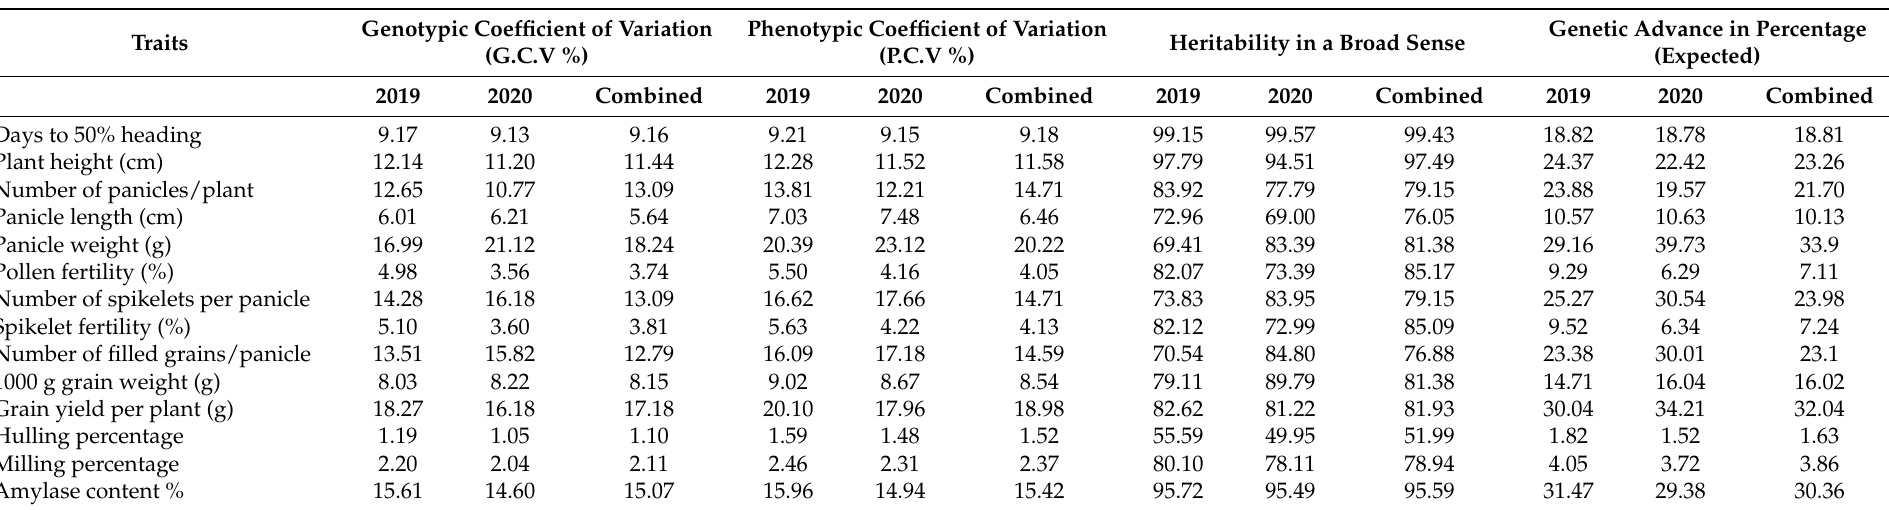
Table 9. The genetic parameters and broad sense heritability of studied traits for studied rice genotypes for the two-year and combined data.